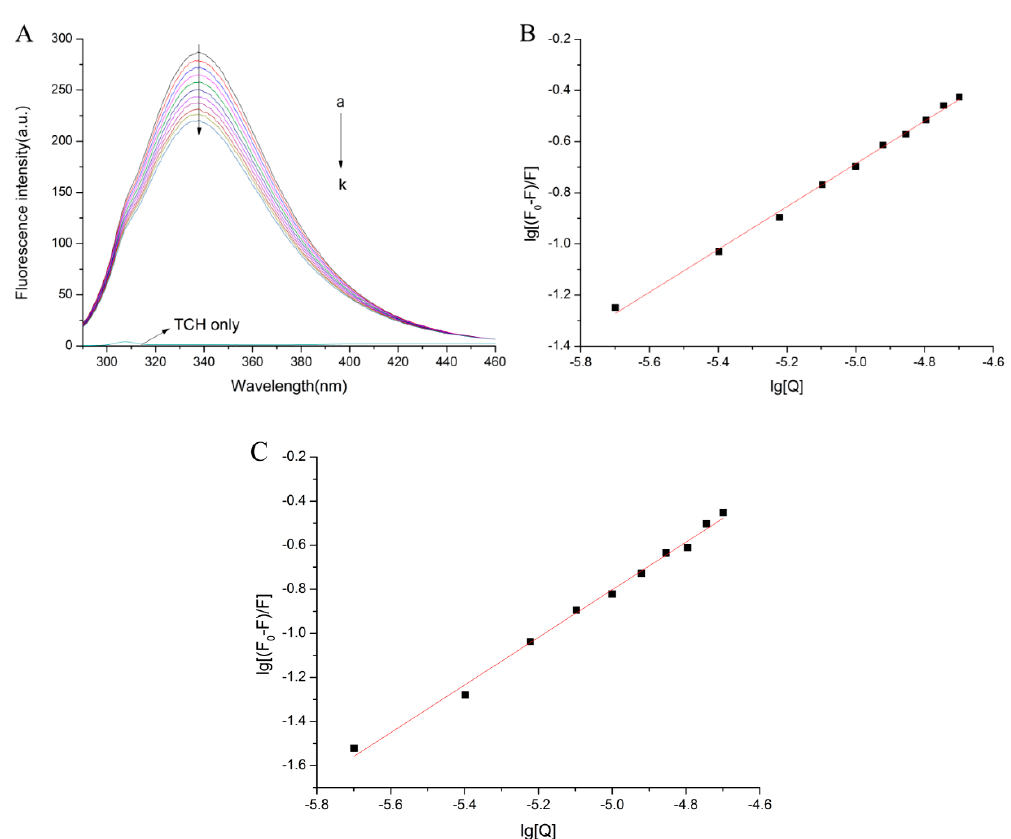
Figure 9. ( A ) The fluorescence quenching spectra about the impact of TCH on bLf and iron ion system (simulated the environment of bLf and iron in milk). Double-log Stern–Volmer plots for the quenching of bLf-Fe 3+ in the absence ( B ) and presence ( C ) of TCH with different concentration of Fe 3+ ion. c (TCH)/c (bLf) =